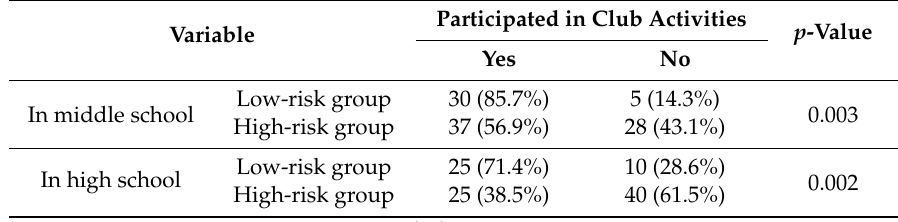
Table 3. Comparison of participants who took part in club activities during middle or high school by locomotive syndrome risk group †